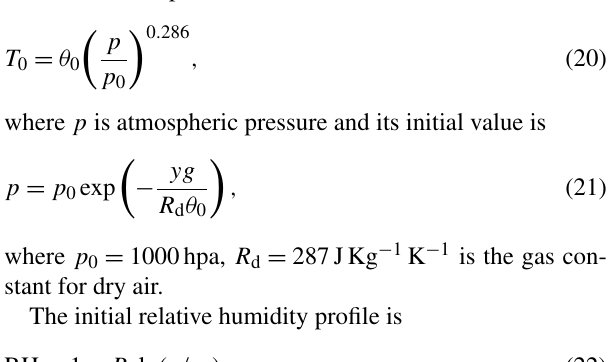
Figure 1. Particle size distribution used in this paper, which fits the results of Schmidt’s (1982) field observations. Table 1. Comparison of D th and D 99%